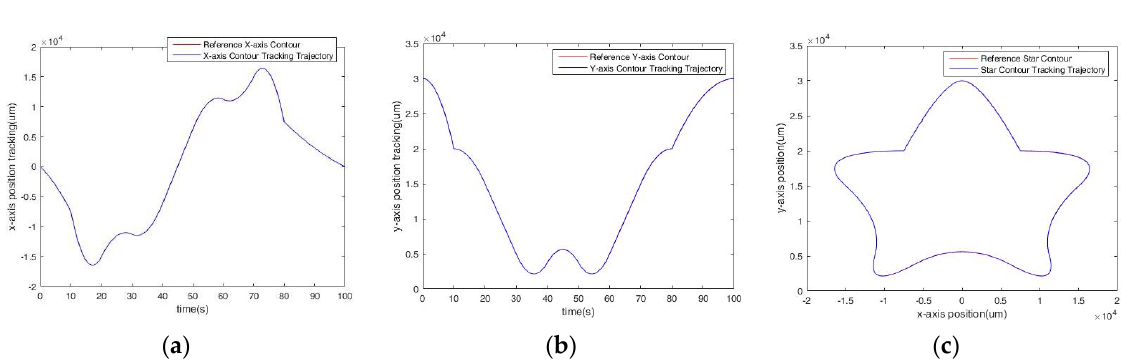
Figure 13. The path trajectory of the experiments. ( a ) The X − axis tracking response, ( b ) the Y − axis tracking response, ( c ) the heart path response.